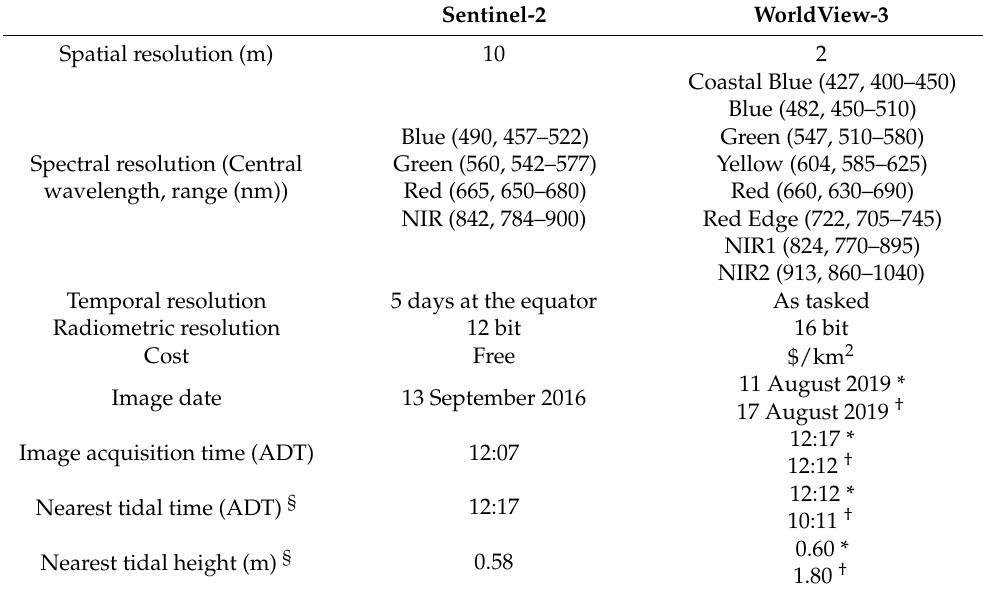
Table 1. Comparison of WorldView-3 and Sentinel-2 spectral and spatial resolutions, and images used in this study. Only the bands used in this study are included. The WorldView-3 central wavelengths are provided by [35] and the range by [36]. Information on the spectral resolution of Sentinel-2 are provided by